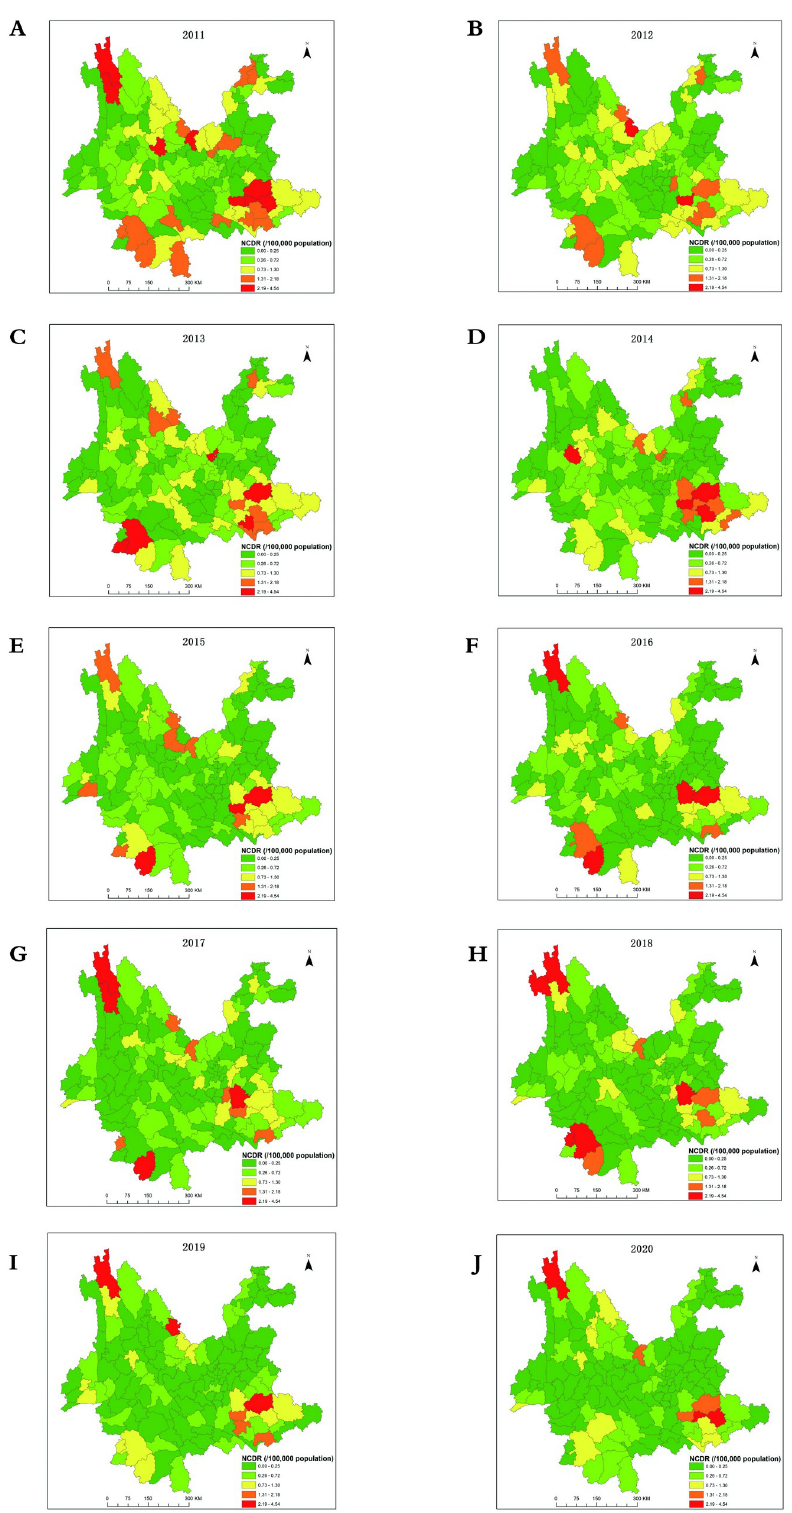
Fig 2. Spatial Distributions of NCDRs of Leprosy Cases in Yunnan, China, 2011–2020. The base layer is from